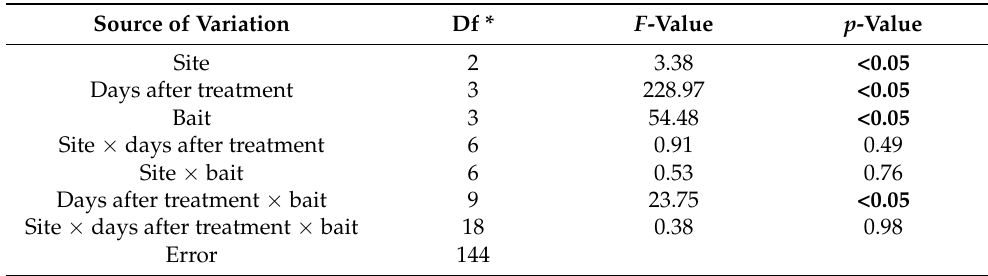
Table 2. Analysis of variance for bait efficacy comparing site, days after treatment and type of bait (error df =